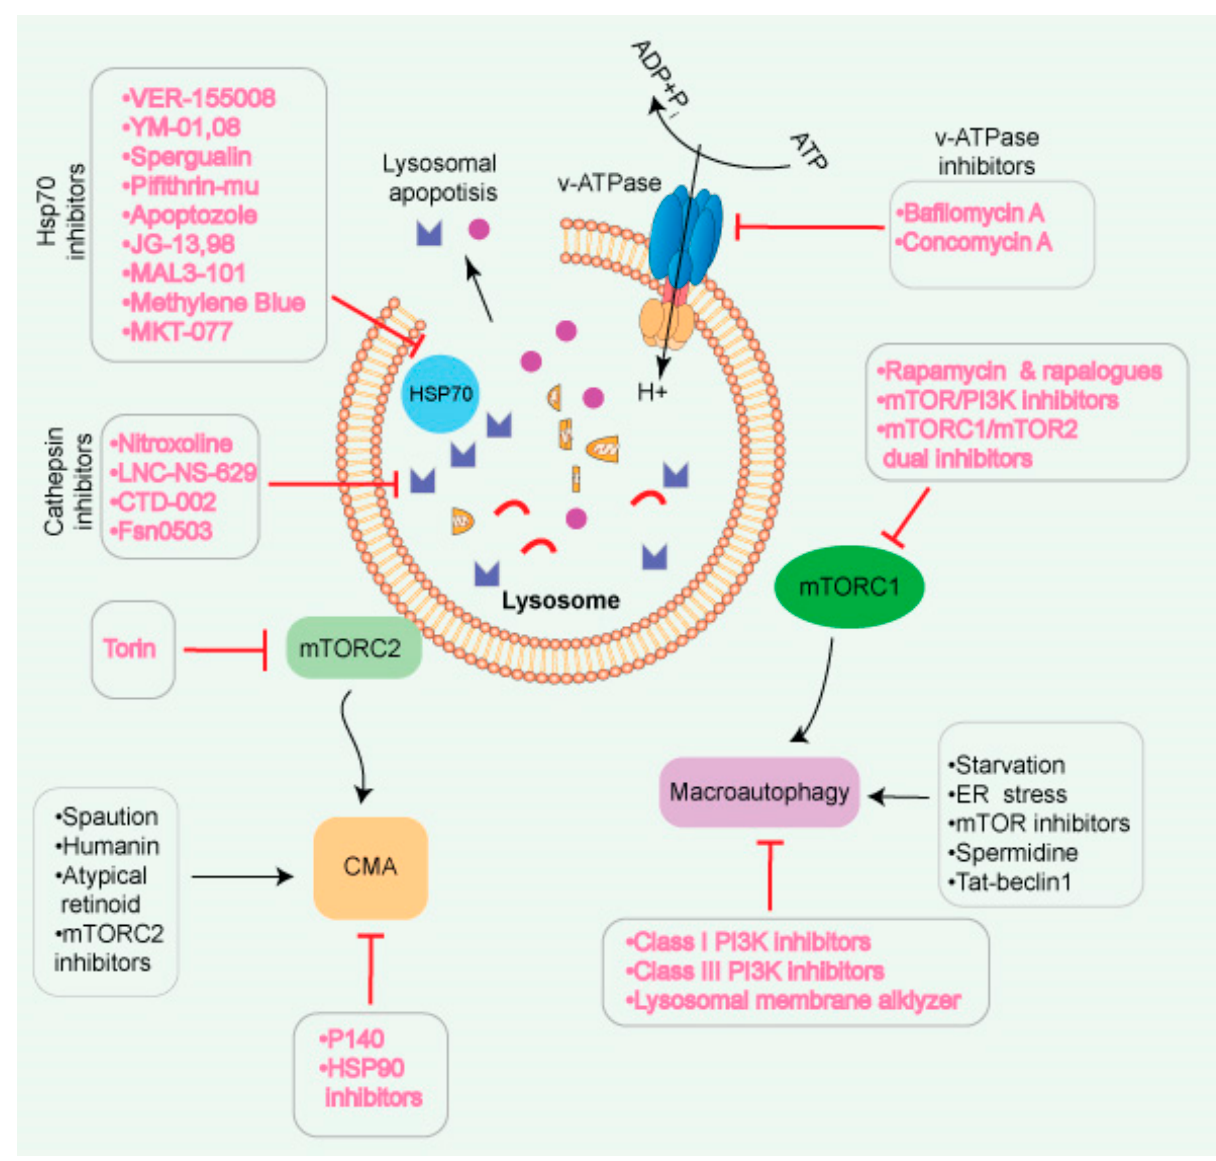
Figure 5. Different strategies for modulation of lysosomes and their functions. Lysosomes are known to link with many signaling pathways, allowing for multiple targeting options. Since autophagic pathways play different roles in cancer, various methods exist to inhibit/suppress or activate lysosomes. Inhibiting mTORC1 may indirectly enhance autophagy. Lysosomotropic chemicals have the potential to disrupt the membrane and thus prevent lysosome fusion. Inhibitors of V-ATPase have an impact on several pH-sensitive lysosomal enzymes. HSP70 inhibitors may be used to enhance the impact of lysosomotropic drugs that protect against HSP70. Lysosomal exocytosis releases cathepsins into the extracellular environment, promoting extracellular matrix breakdown and malignant cell invasion. Cathepsin protease inhibitors have the potential to be utilized as a treatment option.